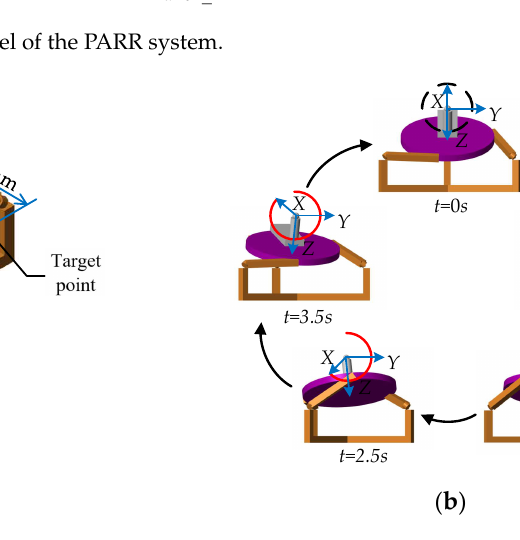
Figure 9. ( a ) Target point; ( b ) circular trajectory.